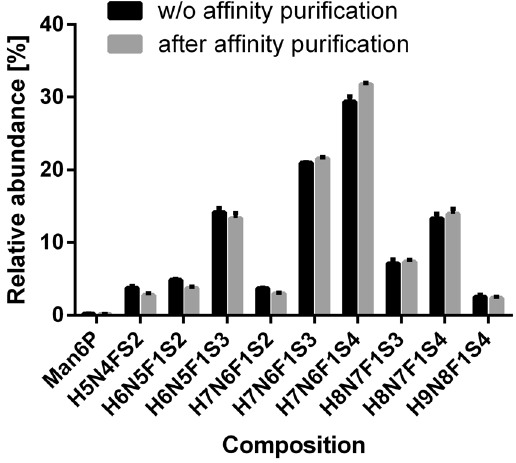
Figure 4. EPO composition selectivity during affinity purification. Profiles obtained with (grey) and without (black) affinity purification are highly similar. Only minor quantitative differences were